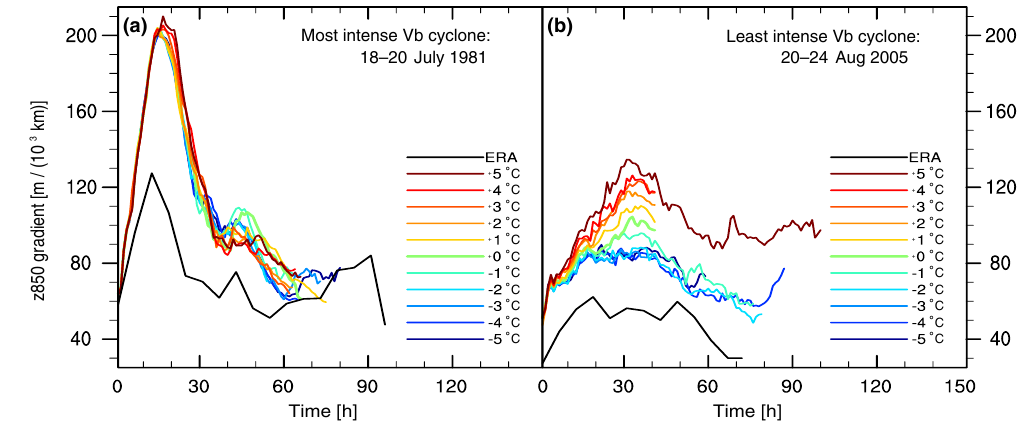
Figure 6. The gradient within an area of 1000 × 1000km 2 for the geopotential height at 850hPa is shown for two different Vb events. The coloured lines indicate changes in the gradient over the time of the Mediterranean SST experiments. The black line shows the evolution in the gradient in the ERA-Interim data for the same event. In panel (a) the most intense Vb event (18–20 July 1981) is shown. In panel (b) , the least intense of the Vb events (20–24 August 2005) is shown. The data based on WRF show an hourly resolution and a spatial resolution of 0.5 ◦ × 0.5 ◦ . The ERA-Interim data are based on 6-hourly temporal resolution, which has been linearly interpolated on 1-hourly temporal resolution, while the spatial resolution is 1.5 ◦ × 1.5 ◦